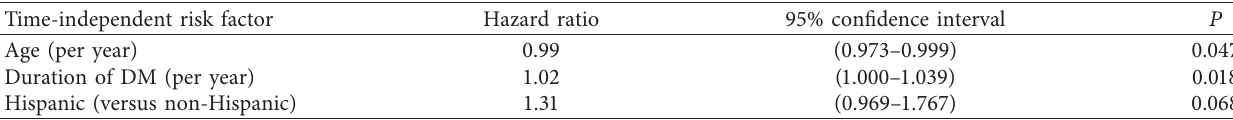
Table 5: Effect of time-independent risk factors in the final model.